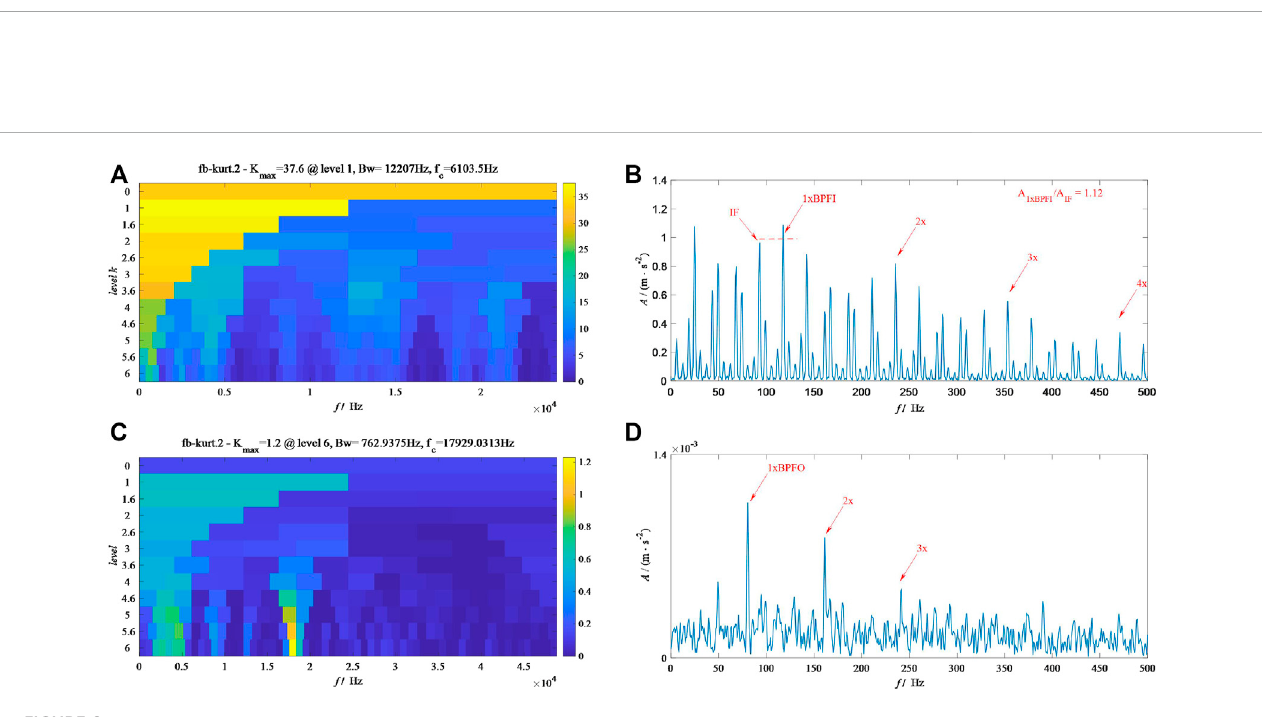
FIGURE 8 Results from FK for the MFPT signals: (A) and (B) correspond to the kurtogram and the corresponding SES of the inner race fault bearing; (C) and (D) correspond to the kurtogram and the corresponding SES of the outer race fault bearing.